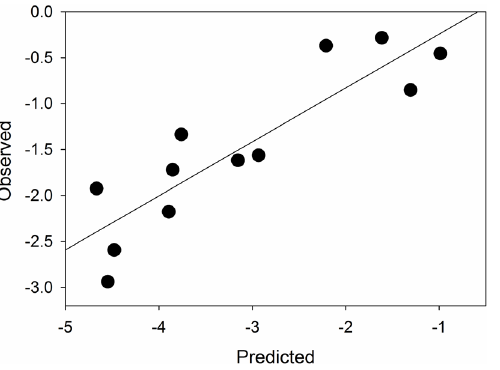
Fig 7. Relationship between observed and predicted lake methane values in pilot lakes sampled in